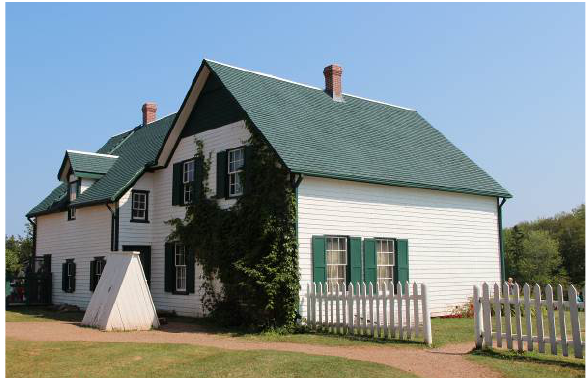
Figure 2. Traditional Wood construction on Prince Edward Island, Canada (Source: